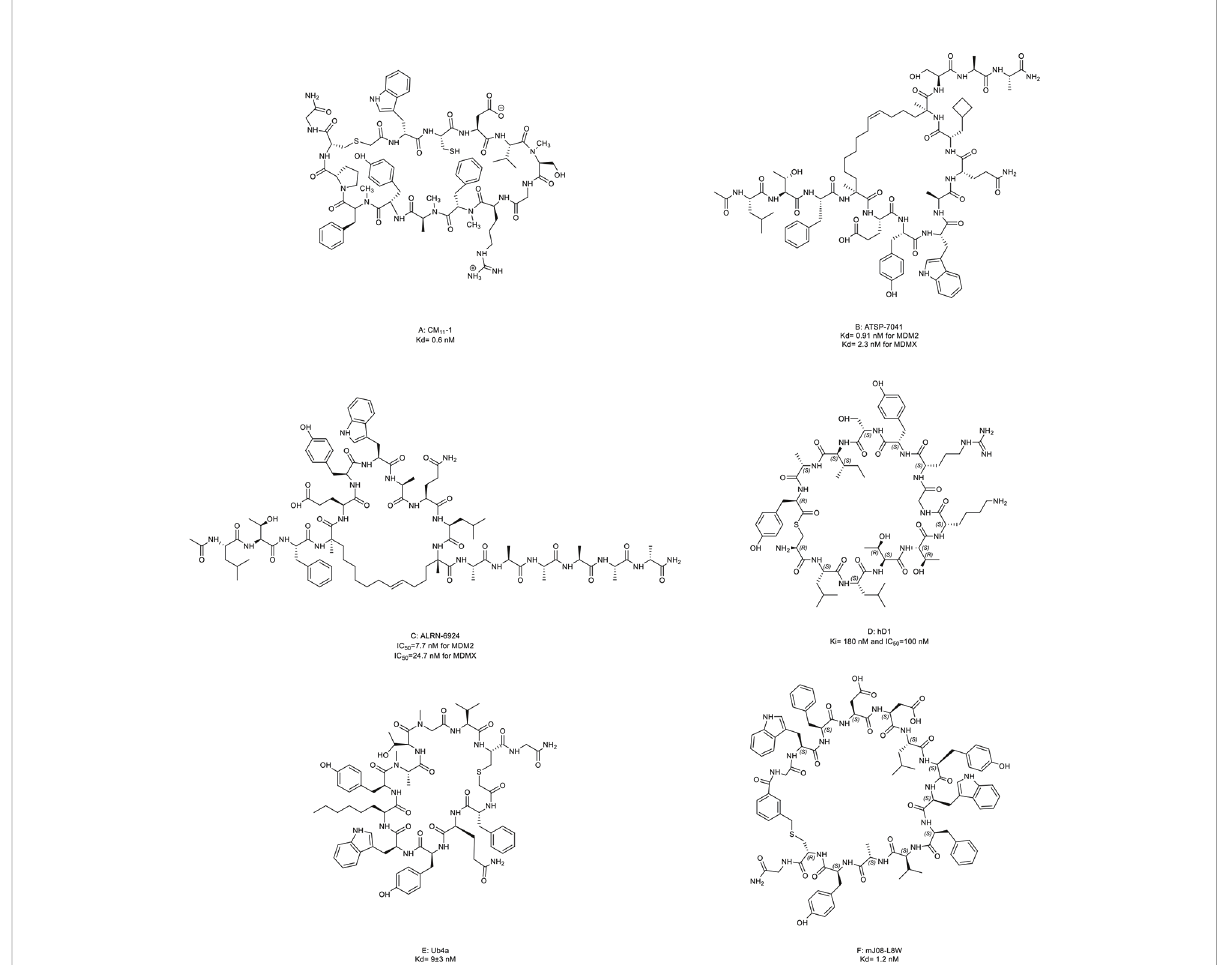
FIGURE 8 Macrocyclic peptides targeting the ubiquitin-proteasome system (UPS). (A) CM11-1, Kd= 0.6 nM; (B) ATSP-7041, Kd= 0.91 nM for MDM2 and 2.3 nM for MDMX; (C) ALRN-6924, IC50=7.7 nM for MDM2 and 24.7 nM for MDMX; (D) hD1, Ki= 180 nM and IC50=100 nM; (E) Ub4a, Kd= 9±3 nM; (F) mJ08-L8W, Kd= 1.2